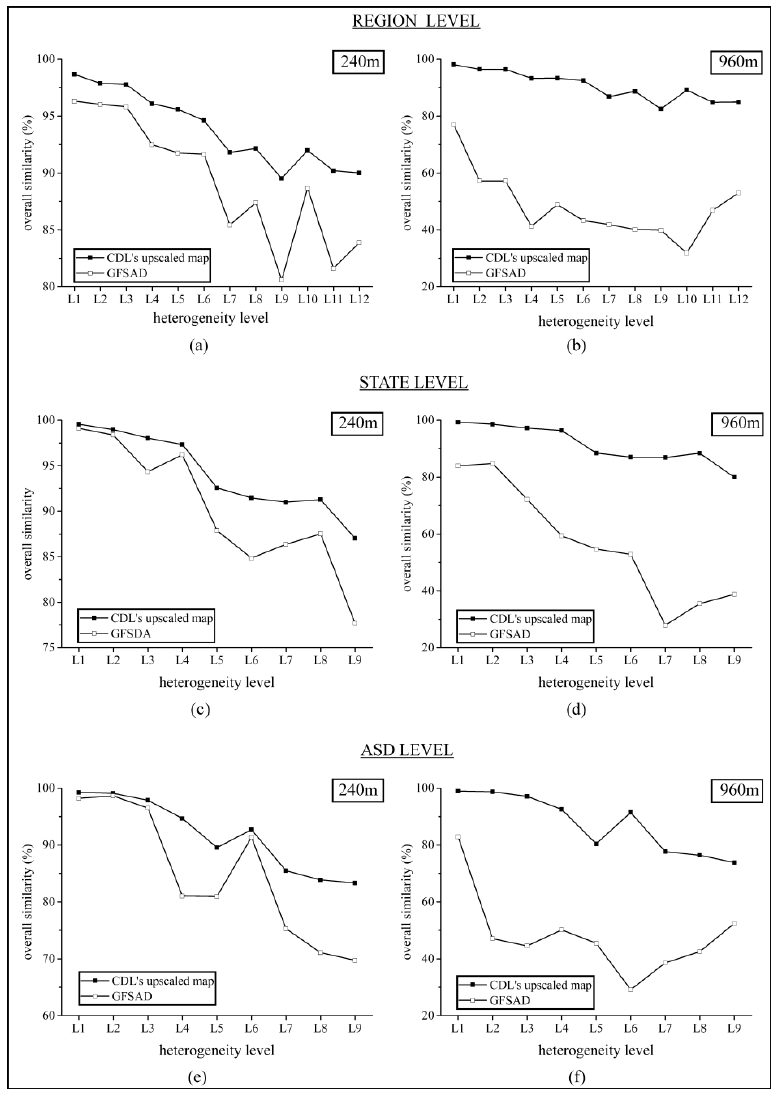
Figure 5. The relationship between heterogeneity and the Overall Similarity (OS). The graphs at ( a , c , e ) show the OS of the upscaled maps at 240 m and the GFSAD maps at 240 m, respectively, for region level, state level and ASD level. The graphs at ( b , d , f ) show the OS of the upscaled maps at 960 m and the Global Food Security-Support Analysis Data (GFSAD) maps at 960 m, respectively, for region level, state level and ASD level. Note L i in the X-axis represents the heterogeneity level of study sites corresponding to each extent level.